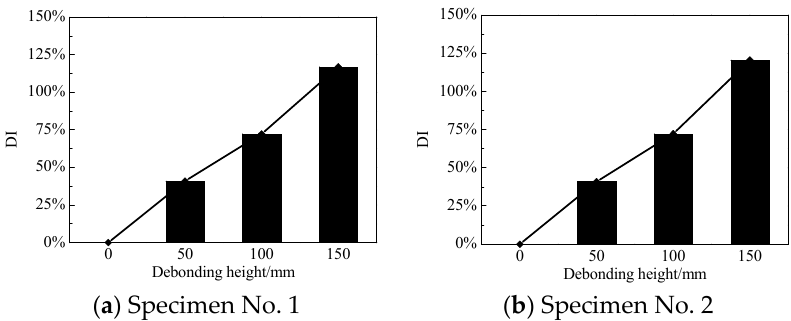
Figure 10. Damage index varying with the height of interface debonding.